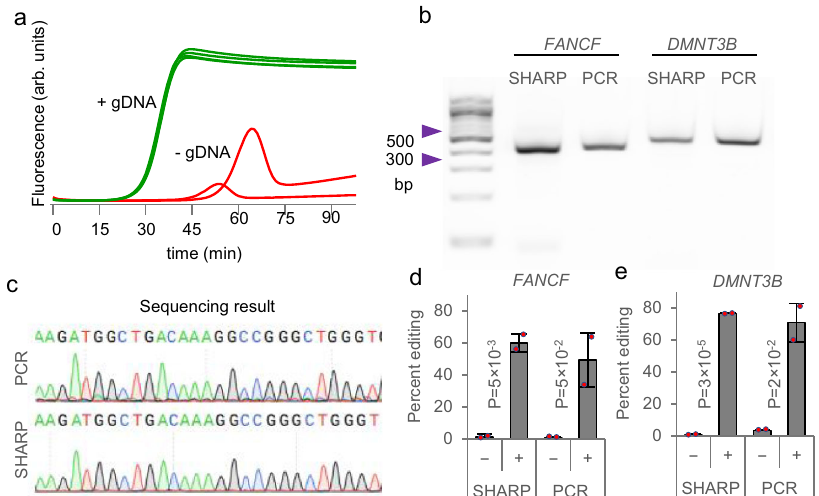
Fig. 4 | SHARP applied to genomic DNA. a The SHARP reaction containing gDNA template (+gDNA) or without template ( – gDNA), along with primers intended to amplifya474bpregionnearthe DMNT3B gene,wasincubatedat60°C.Theextent ofampli fi cationwasquanti fi edbymeasuringDNA fl uorescenceusingtheEvaGreen dye as a function of time. b Agarose gel electrophoresis of genomic ampli fi cation product using SHARP versus PCR, amplifying a 410bp region near FANCF or a 474bp region near DMNT3B . c Sanger sequencing of genomic ampli fi cation pro- duct near DMNT3B using SHARP versus PCR. d-e Quanti fi cation of genome editing